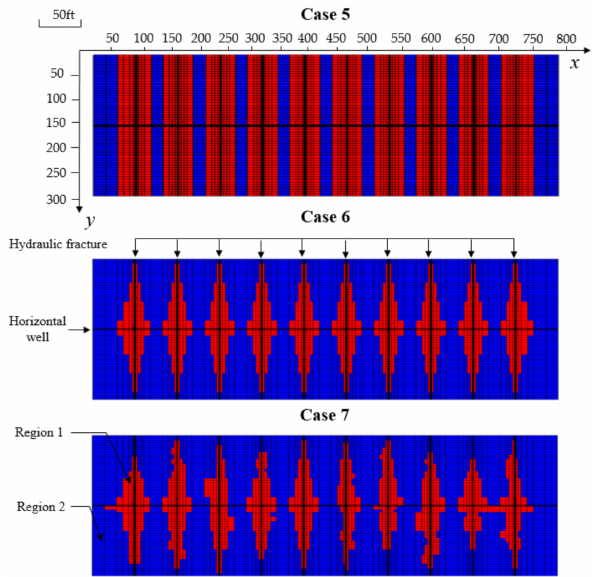
Figure 6. Reservoir grid for multifractured horizontal well